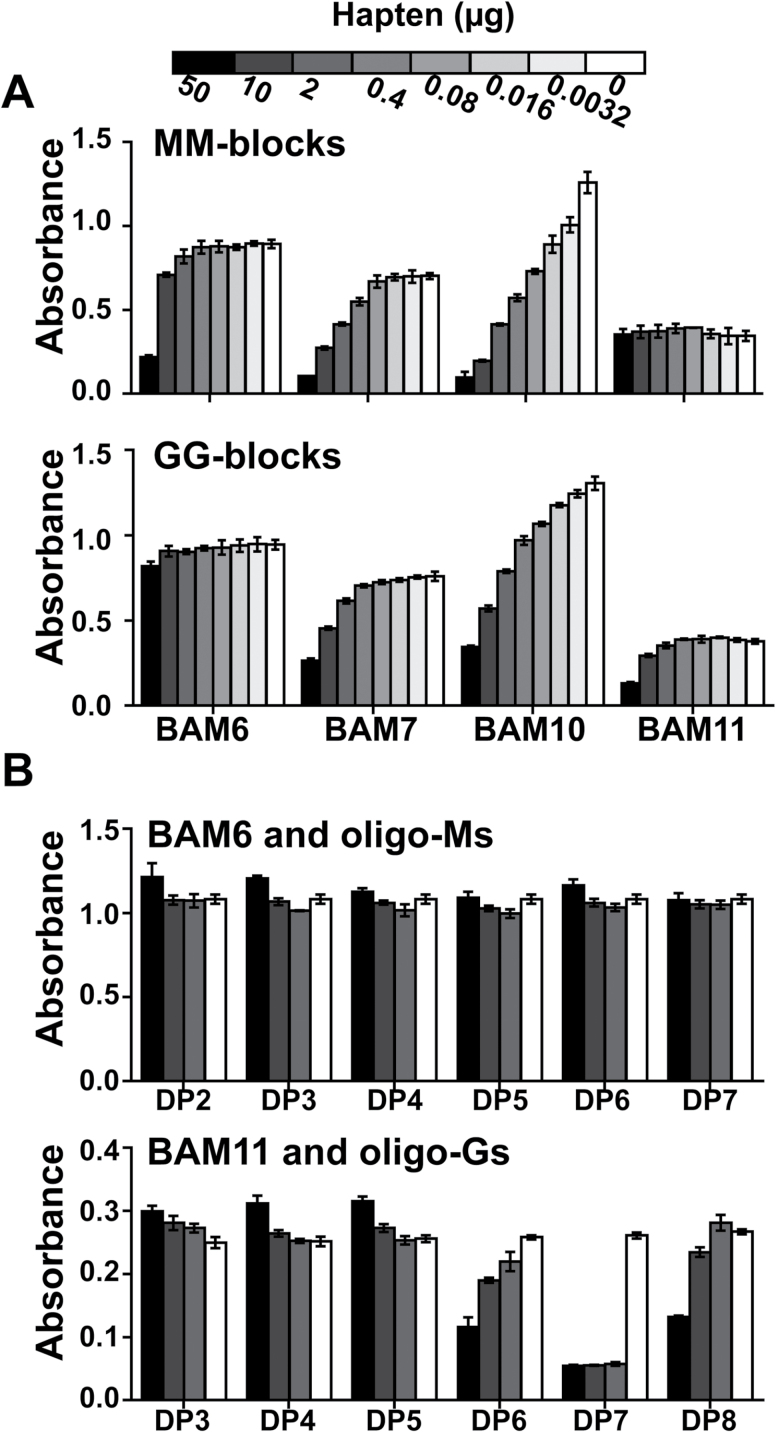
Alginate hapten inhibition ELISAs with alginate antibodies. (A) Competitive inhibition ELISAs with MM-blocks and GG-blocks of alginates with BAM6, BAM7, BAM10, and BAM11. Results are means of four replicates, and error bars represent the SD. (B) Competitive inhibition ELISAs with defined oligoalginates. BAM6 with DP2–DP7 oligomannuronates and BAM11 with defined DP3– DP8 oligoguluronates. Results are means of four replicates, and error bars represent the SD.